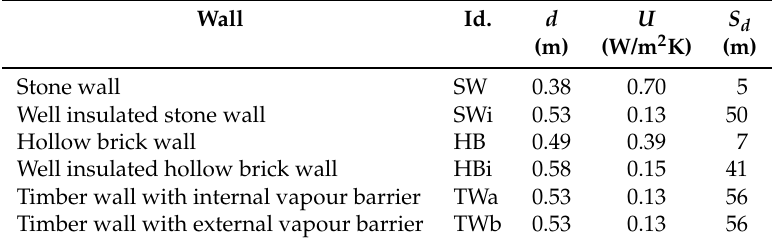
Table 4. Description of the considered walls. The variables presented in the table are wall thickness d , thermal transmittance U and equivalent air layer thickness for the vapour diffusion S d of the walls considered for the risk assessment evaluations. The walls are identified in Figure